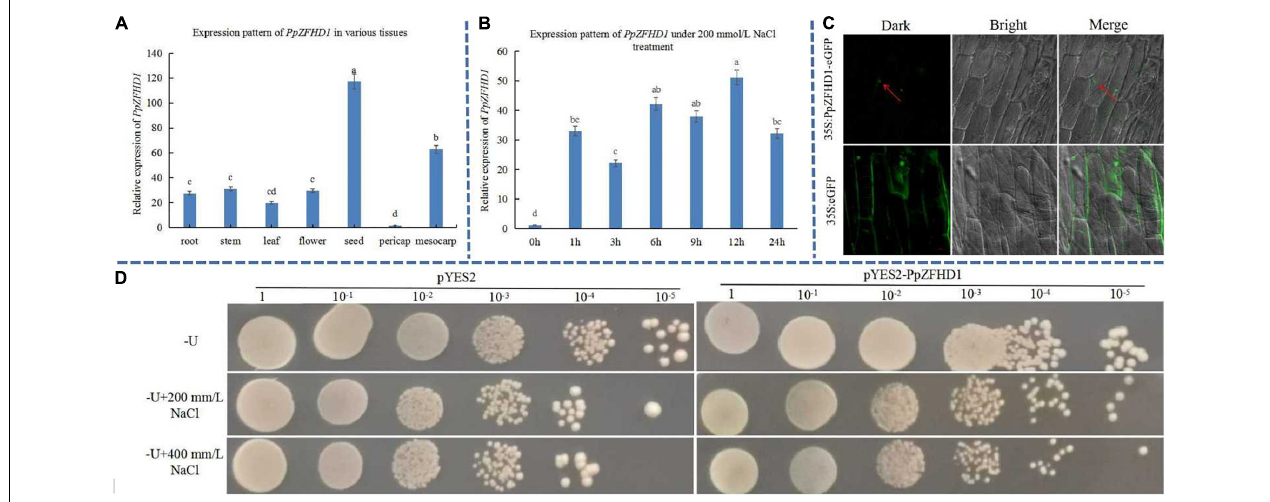
FIGURE 5 | Expression pattern, subcellular localization of PpZFHD1 , and growth status of yeast over-expressing PpZFHD1 responsive to high salt stress. (A) Expression pattern of PpZFHD1 in various tissues. (B) Expression pattern of PpZFHD1 under 200 mM NaCl. (C) Detection of subcellular localization of PpZFHD1. (D) Growth status of yeast over-expressing PpZFHD1 responsive to high salt stress. Red arrows indicate where a green fluorescence signal was detected in the nucleus. Different lower-case letters indicate significant differences between means as measured by ANOVA followed by Duncan’s multiple range test ( P < 0.05, the same